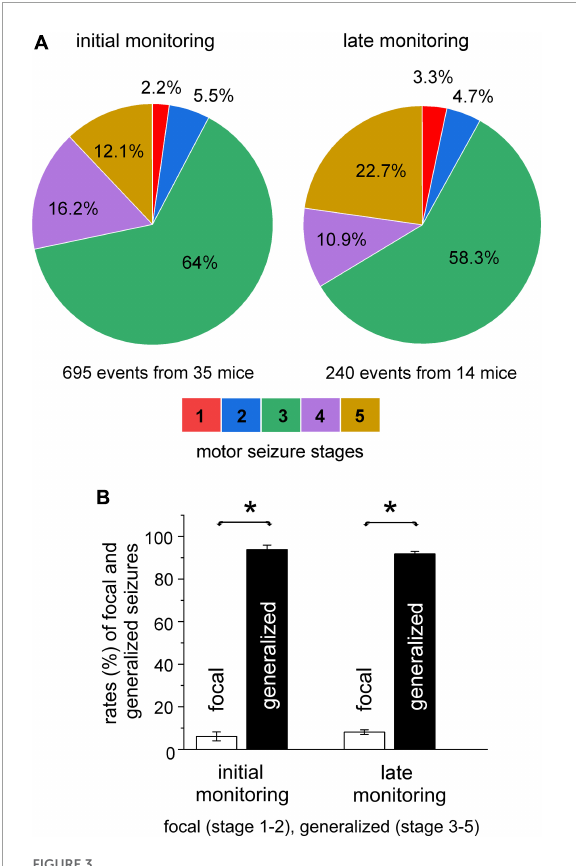
FIGURE3 Severities of spontaneous motor seizures. Spontaneous recurrent seizures (SRS) were detected within 10 days or 6–12 weeks (initial or late monitoring period) after termination of kindling stimulation. Data were collected from mice of the five implantation groups. Motor seizure severities were scored using the modified five racine stages. (A) Summed proportions of motor seizure stages in the initial (left) and late (right) monitoring periods. (B) Summed rates of focal (stage 1–2) and generalized (stage 3–5) motor seizures for the two monitoring periods. Note that the rates of generalized or focal seizures were not significantly different between the initial and late monitoring period but rates of generalized seizures were significantly greater than those of focal seizures in both the monitoring periods (* p ≤ 0.05, one-way